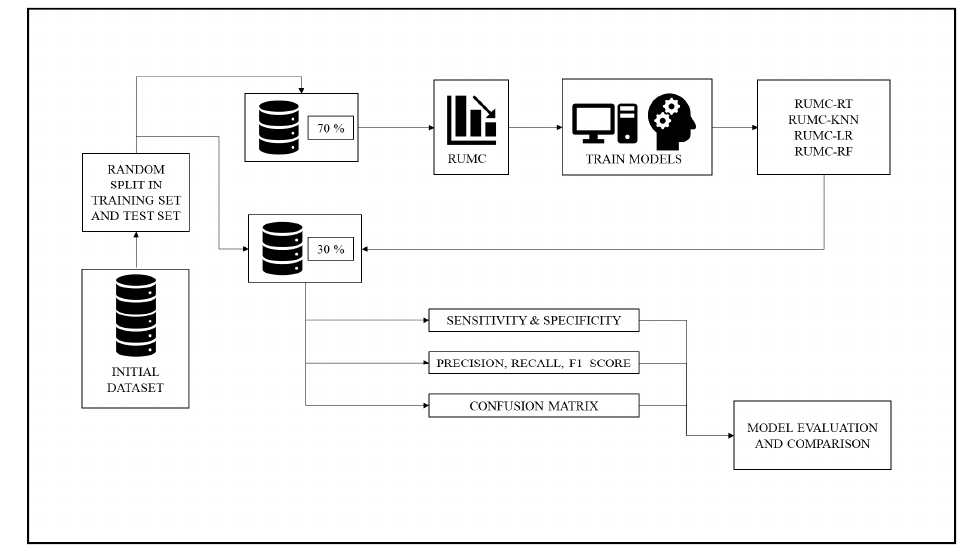
Figure 2. The workflow of the second phase.